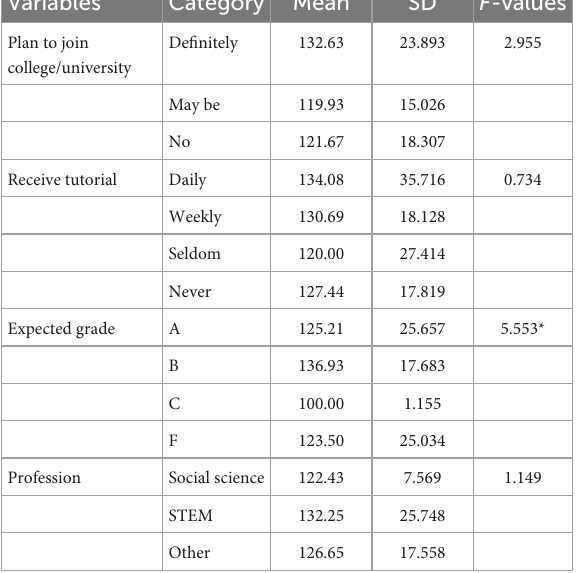
TABLE 5 Proportions of students with high and low mathematics